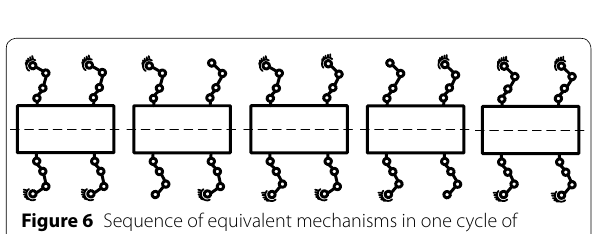
Figure 6 Sequence of equivalent mechanisms in one cycle of trotting gait